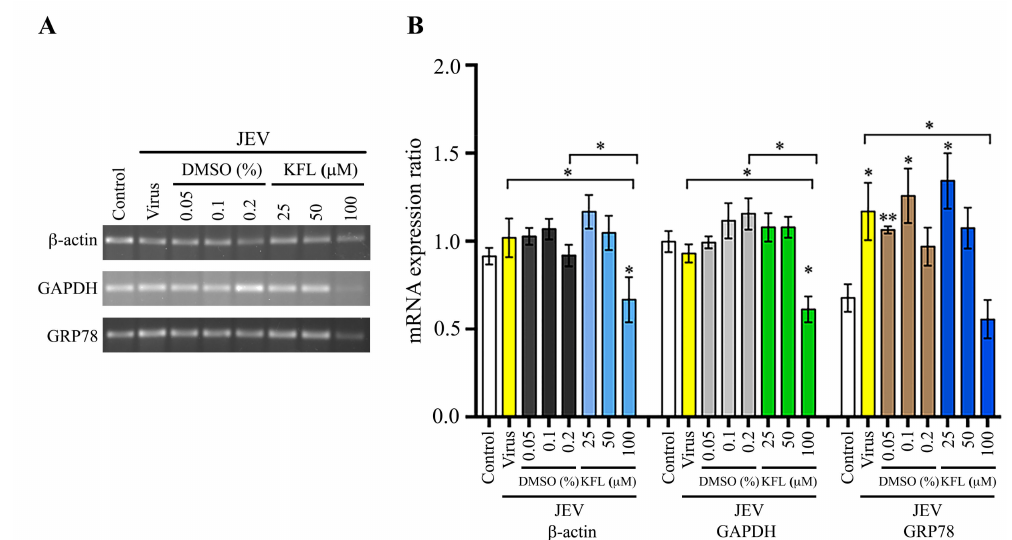
Figure 9. E ff ect of kaempferol treatment on gene transcription of BHK-21 cells infected with JEV. BHK-21 cells were infected with JEV at MOI 2 and subsequently incubated with varying concentrations of kaempferol or vehicle control for 24 h after which expression of β -actin, GAPDH and GRP78 was determined by semi-quantitative PCR ( A ). The band intensity was quantitated using ImageJ analysis software and analysed by GraphPad Prism7 program. The relative expression level of all transcripts was quantitated against the average value and the analysis is presented as bar graph ( B ). Experiment was undertaken independently in triplicate and data was normalized against the average signal for all conditions. Error bars represent SD, *; p value ≤ 0.05, **; p value ≤ 0.01. Statistical significance was derived from comparison with the control or with the corresponding DMSO control where indicated.